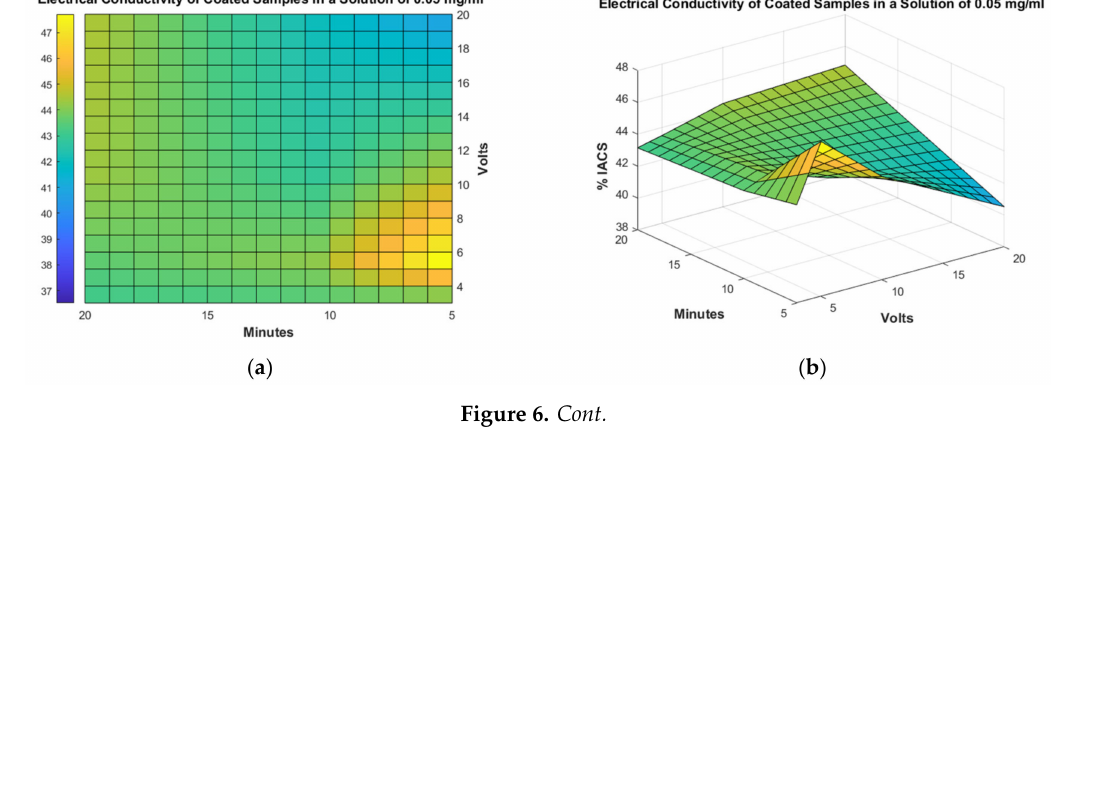
Figure6. Electricalconductivity(%IACS)measurementsperformedatdi ff erentMWCNTconcentrations. ( a ) Top view and ( b ) schematic view of the %IACS for metallic samples coated in a solution of 0.05 mg / mL of MWCNT. ( c ) Top view and ( d ) schematic view of the %IACS for metallic samples coated in a solution of 0.10 mg / mL of MWCNT. ( e ) Top view and ( f ) schematic view of the %IACS for metallic samples coated in a solution of 0.20 mg / mL of MWCNT. Experimental results show that electrical conductivity on the surface of the coated Al6061 samples improves them with lower deposition times and applied voltage for small solution concentrations of MWCNT used in EDP. For higher concentration solutions of 0.20 mg / mL of MWCNT, the %IACS increases for higher voltages and prolonged deposition times.